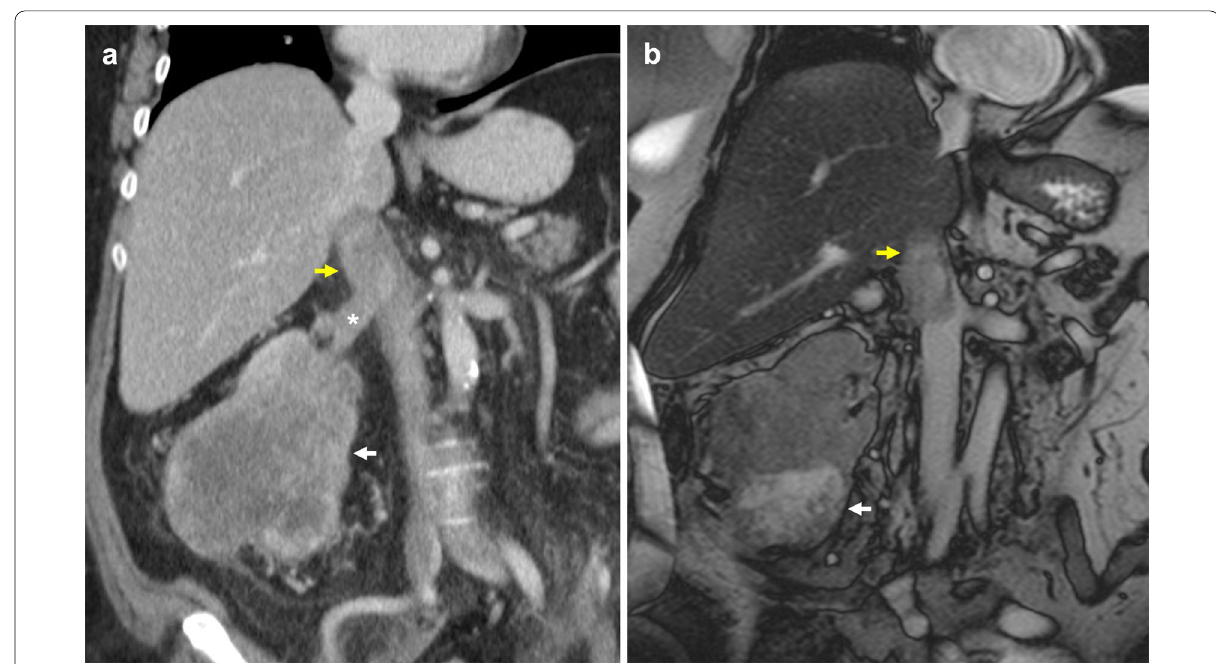
Fig. 16 Renal cell carcinoma with Mayo level III thrombus. a Coronal CT shows a large heterogeneous renal mass (white arrow), expanded right renal vein (asterisk) and heterogeneous enhancement extending into the suprarenal IVC (yellow arrow) in keeping with tumour thrombus ( b ) T2-weighted coronal image confirms extension of tumour thrombus into the suprarenal and intrahepatic IVC (yellow arrow), which returns similar heterogeneous T2 signal as the primary renal cell carcinoma (white